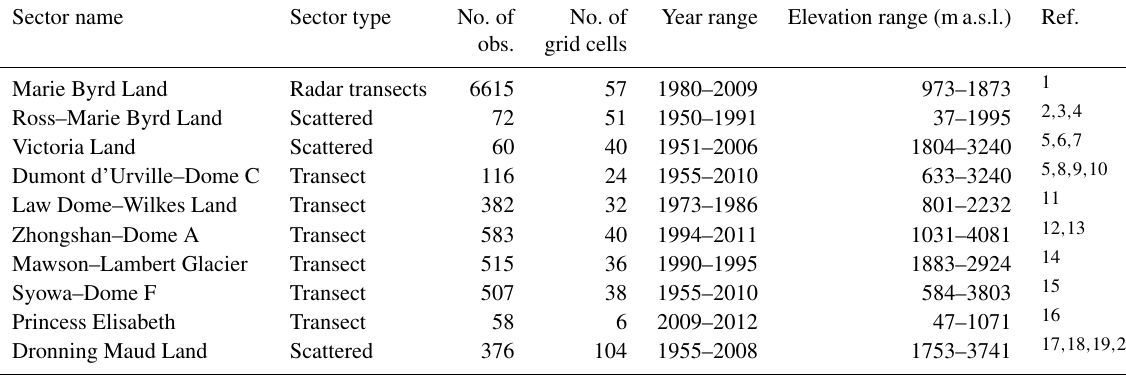
Table 1. Sectors extracted from the GLACIOCLIM-SAMBA database.